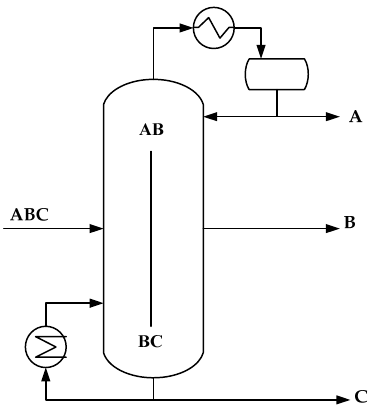
Figure 1. Petlyuk column configuration.